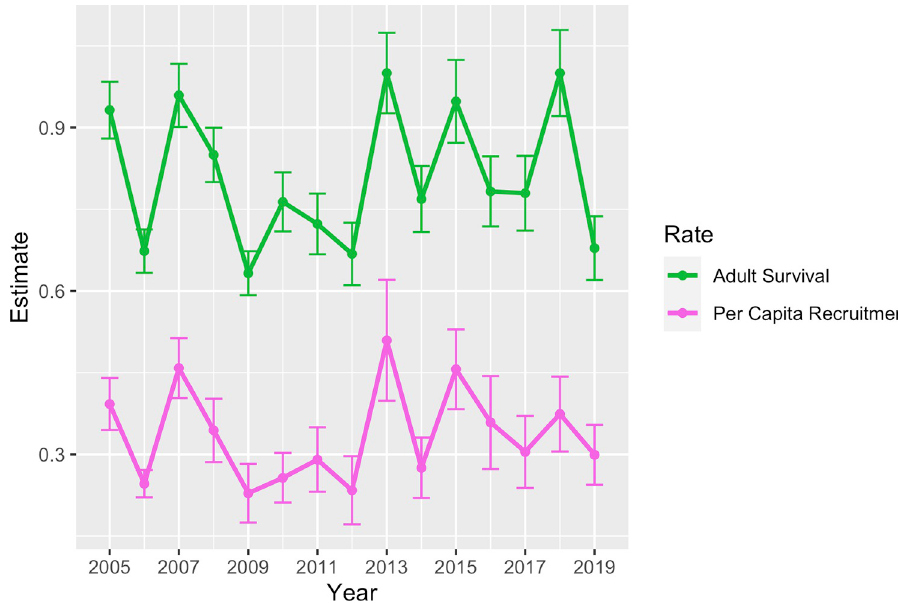
Fig 2. Moose adult survival and fecundity estimates. Estimated trends in annual survival (top) and per-capita recruitment (number of calves that survived to 1 year per adult female alive during the previous year) for moose in Minnesota (thick solid lines) between 2005 and 2019 based on statistical population reconstruction using integrated population models (IPMs), along with associated standard errors (error bars).